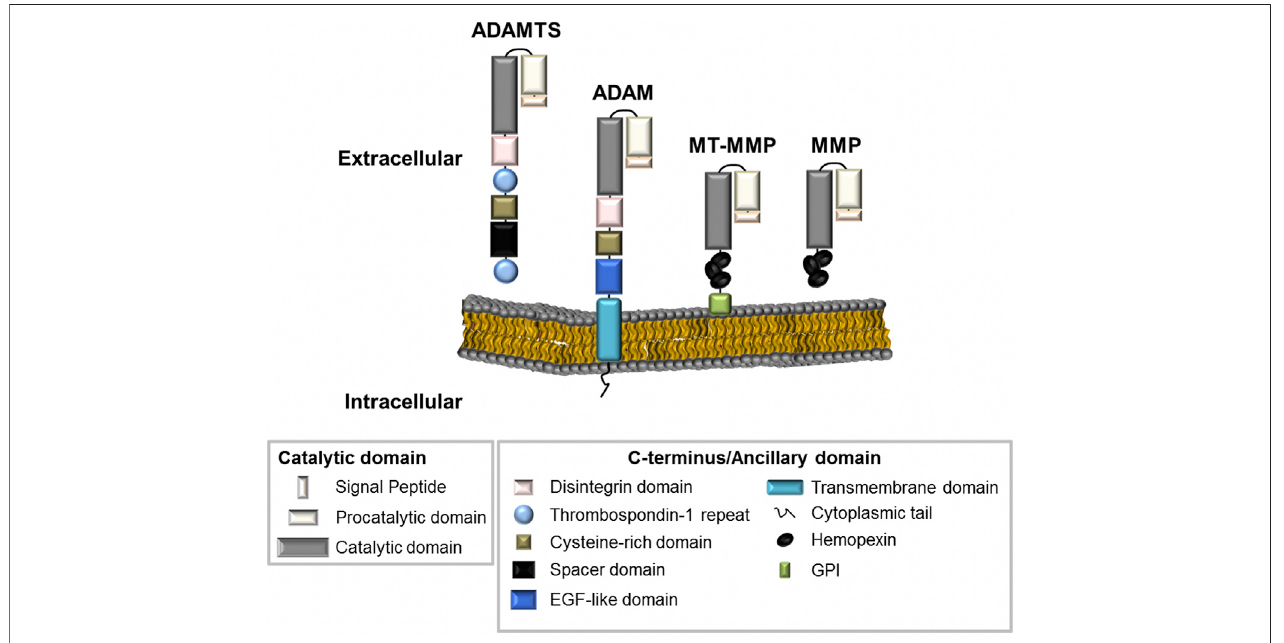
FIGURE 1 | The metalloproteinase superfamily. The basic structural organisation of ADAMTS, ADAM and MMPs family members (including MMPs with a transmembrane domain, MT-MMP). Metalloproteinases generally contain similar proteinase domains. Differences in structure can be seen at the C-terminus or at the ancillary domain where ADAMTS enzymes contain Thrombospondin repeats; ADAMs are membrane-anchored through a transmembrane domain; and MMPs contain haemopexin-like regions.